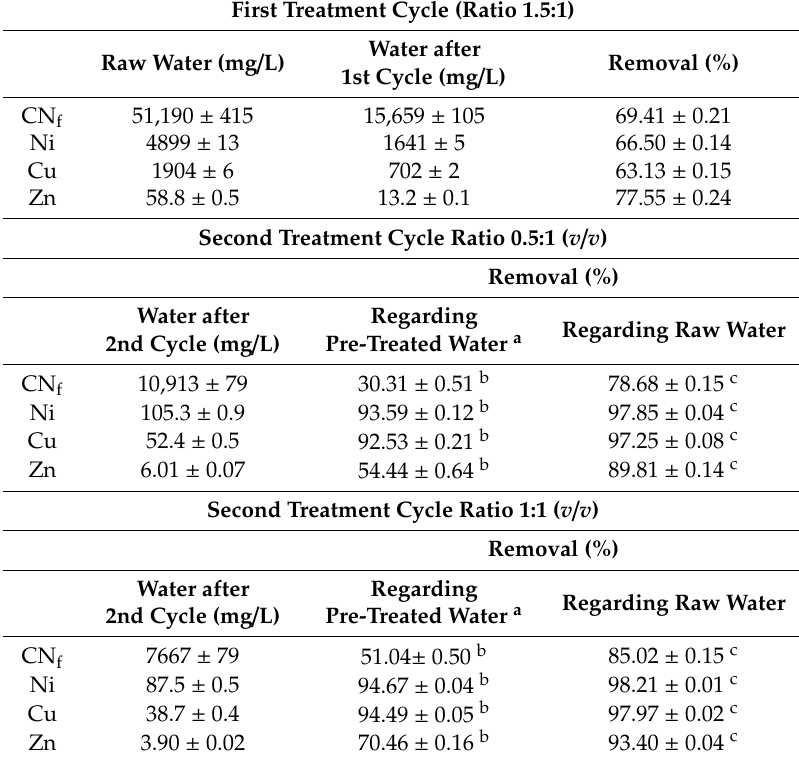
Table 3. Percentages of removal of cyanide and heavy metals after two successive treatment cycles with calcium alginate hydrogel beads (CAB). The first cycle was carried out using a ratio (1.5:1 v / v ) between bioadsorbent / raw wastewater and in the second cycle were used two di ff erent ratios (0.5:1 and 1:1 v / v ). First Treatment Cycle (Ratio